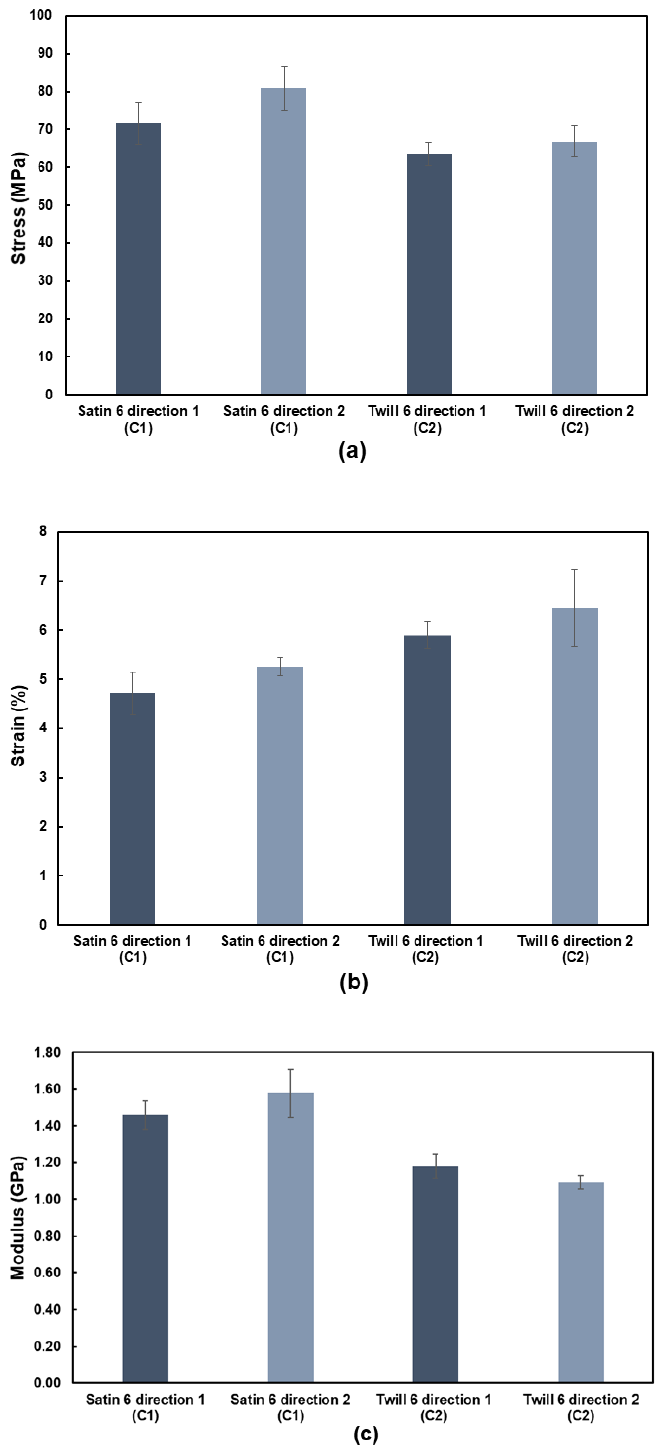
Figure 10. ( a ) Tensile strength of composite materials; ( b ) strain at the maximum strength; ( c ) mod-